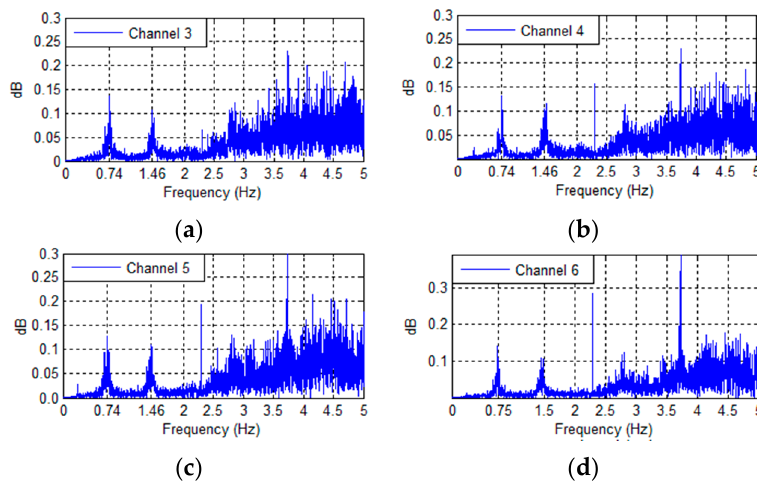
Figure 13. Base Rocking in the Green Building; along the NS and EW axis ( Left and Middle ). Rocking consists of a rigid-body rotation (exaggerated) and pile uplift and sinking ( Right ).